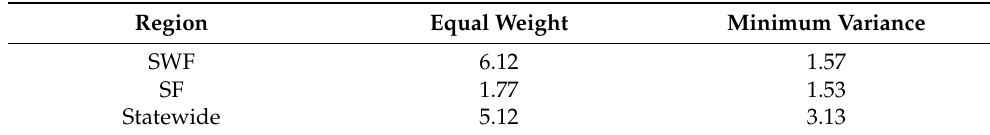
Table 7. The standard deviation of capital cost per one unit of capacity for a combination of individual project